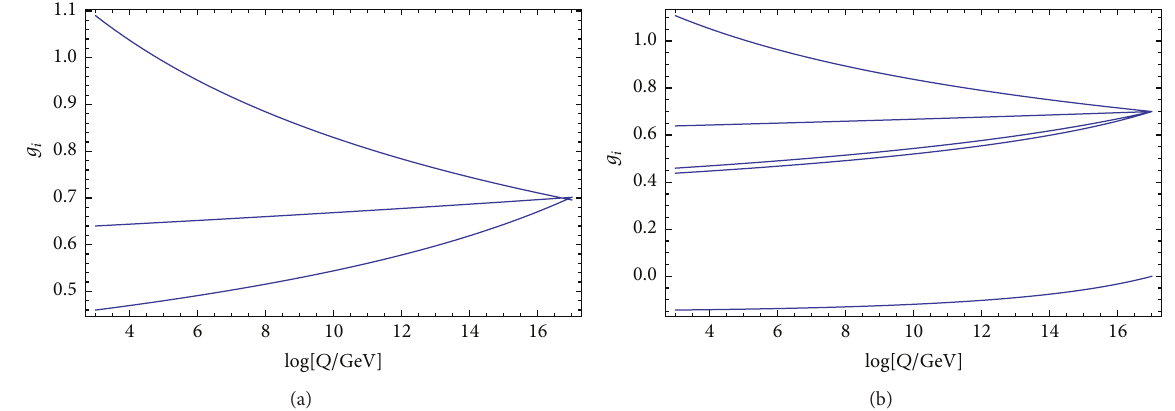
Figure 8: On the left: running of the three gauge couplings in the MSSM limit; on the right: running in the 𝐵 - 𝐿 -SSM including gauge-kinetic